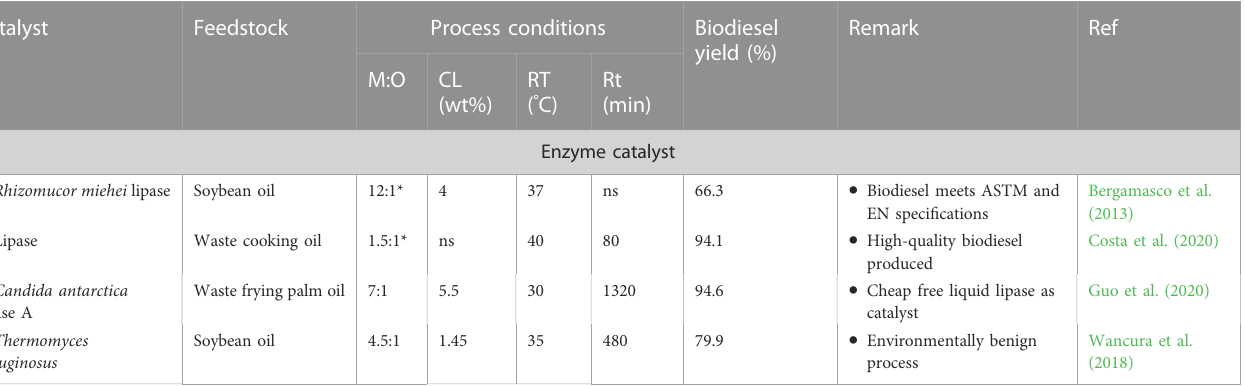
TABLE 3 ( Continued ) Categories of catalysts used for biodiesel